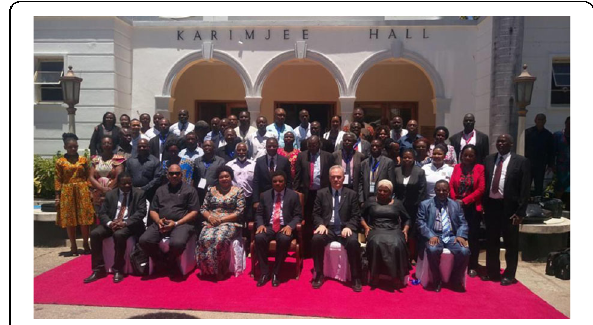
Fig. 2 Launch of the OH strategic plan 1015-2020 and One Health Coordinating Desk in Dar es Salaam. Courtesy: Preparedness and Response Project,